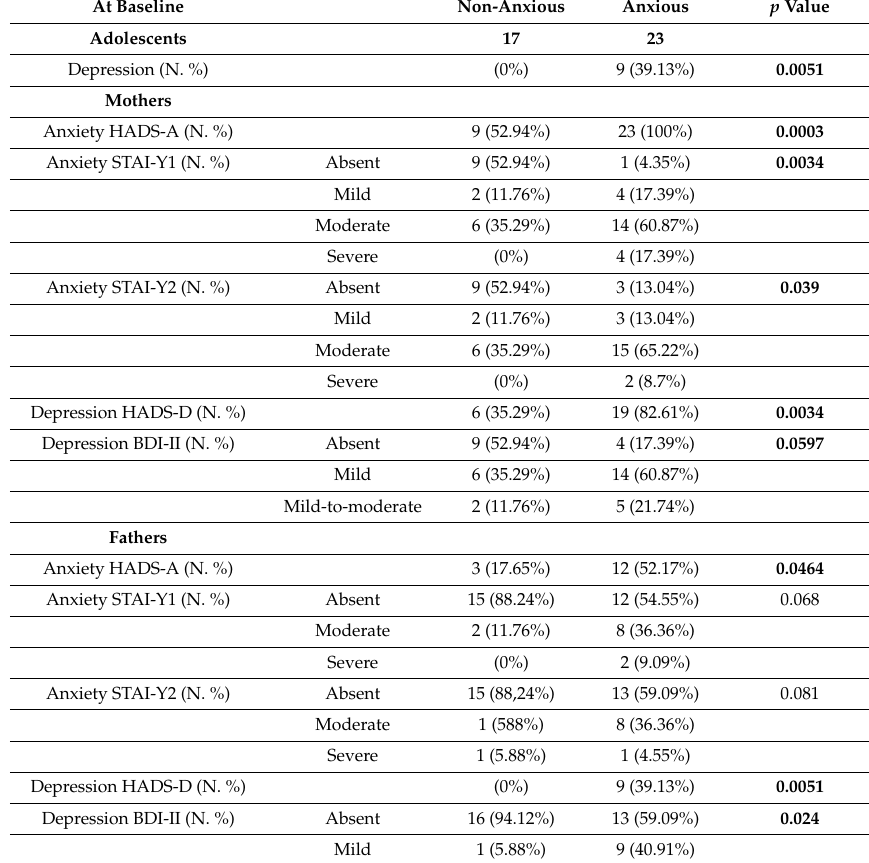
Table 1. Emotional data in non-anxious and anxious adolescents with severe asthma and their parents at